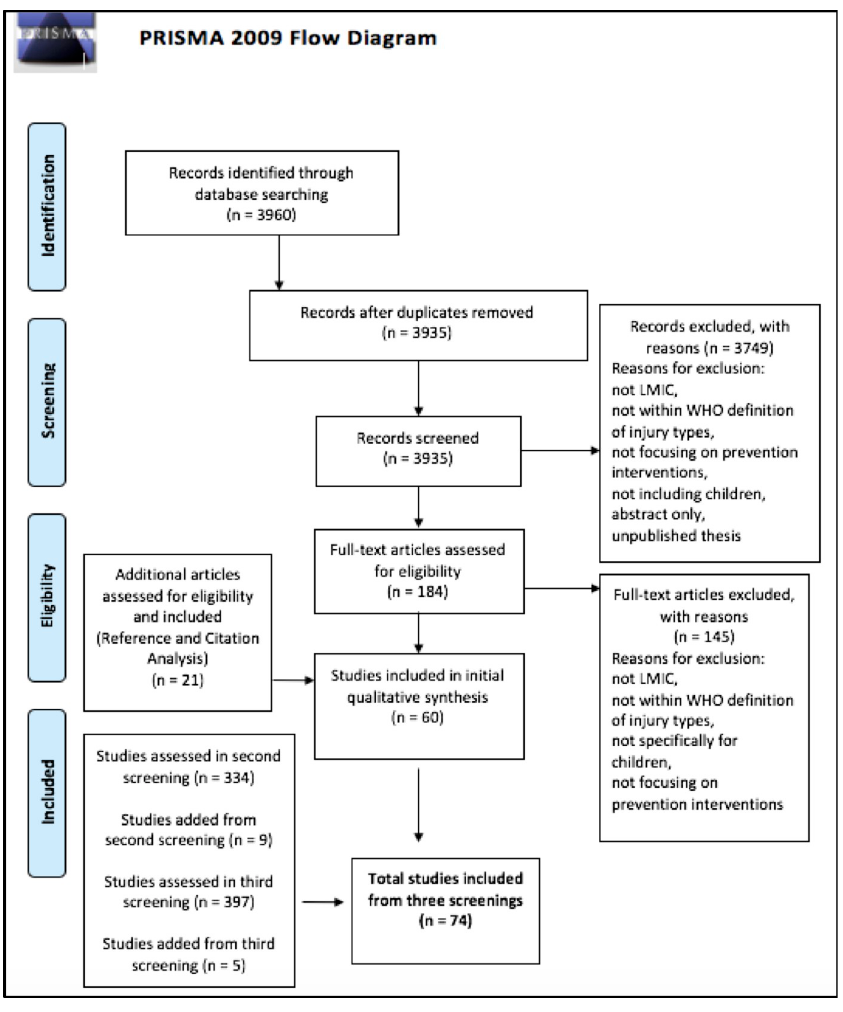
Fig 1. PRISMA flow